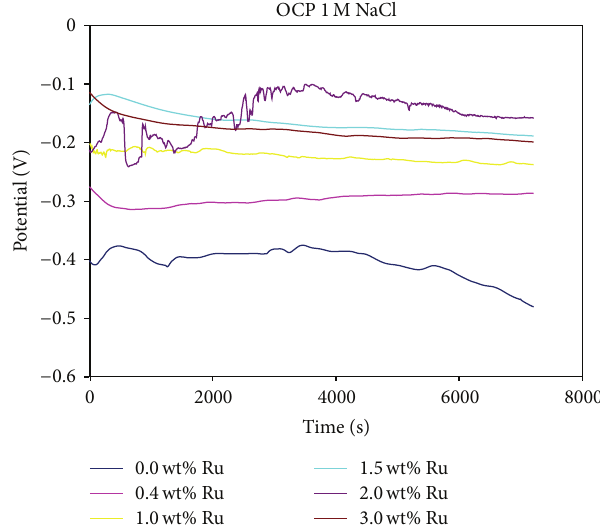
Figure 1: Open circuit potential results of the samples exposed to 1M